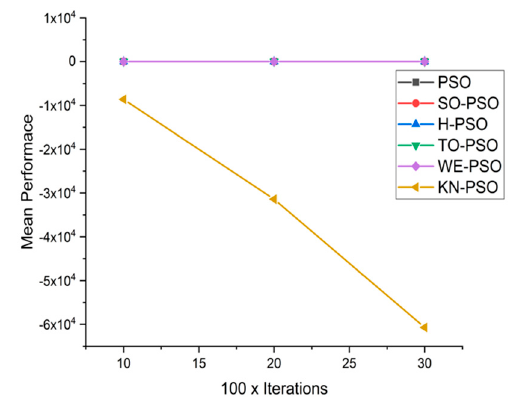
Figure 8. Convergence curve on fn2.